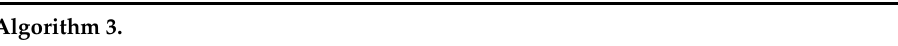
Figure 3. Some special forms of the edge curves.